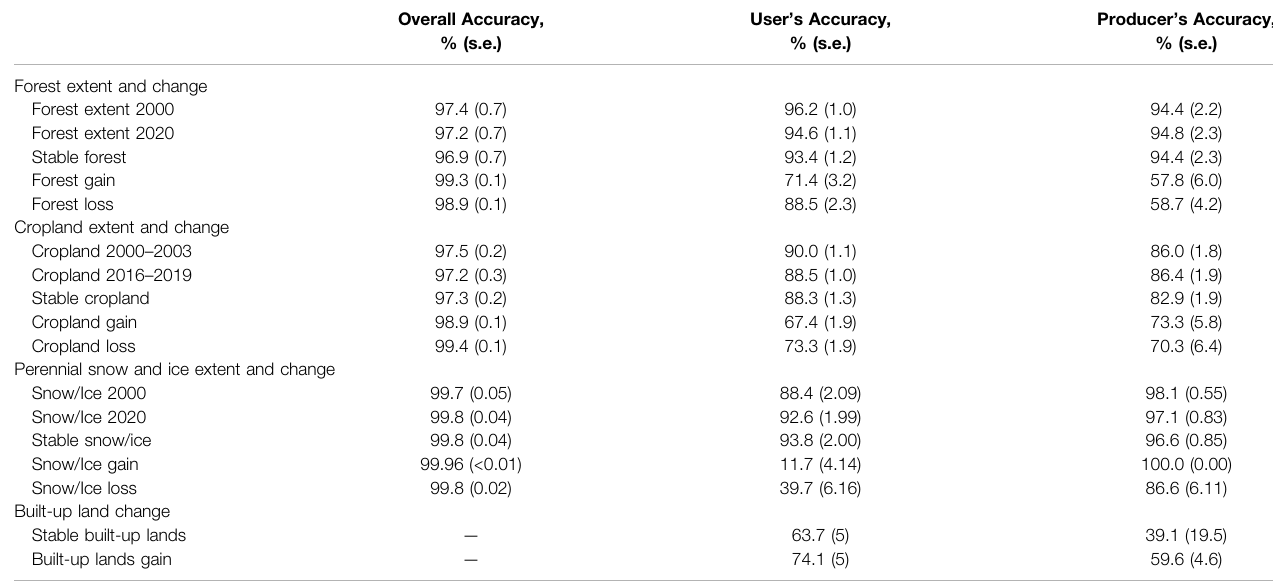
Overall Accuracy, % (s.e.)